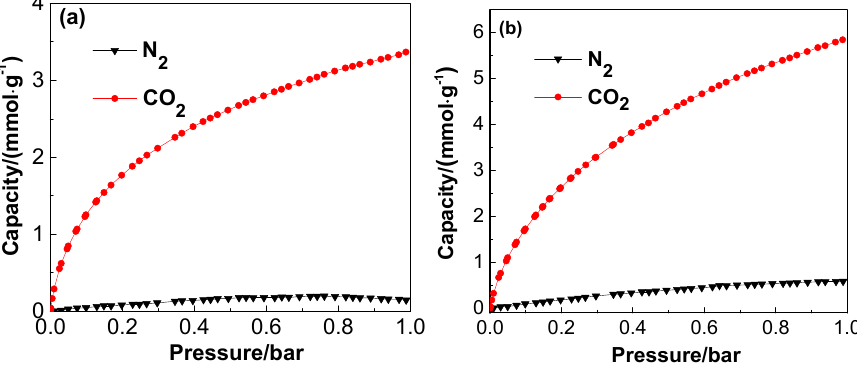
Figure 11. CO 2 and N 2 adsorption isotherms at 273 K on the PUF/C-CO 2 -1173 ( a ) and PUF/C-KOH- 973 ( b ).